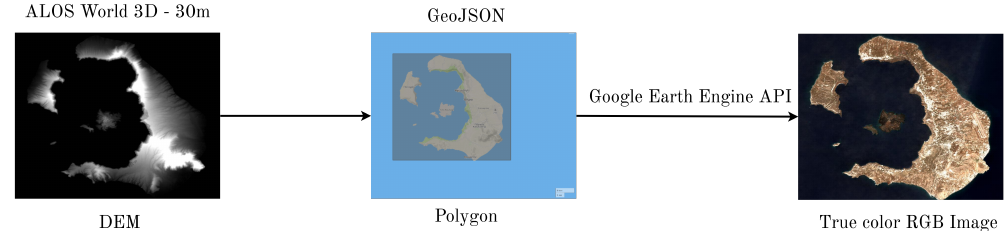
Figure 3. Flow chart of the satellite-imagery dataset collection process using the Google Earth Engine API. The outermost points of the georeferenced DEM are selected as the boundary for the GeoJSON Polygon, which when fed into the API returns the corresponding RGB satellite image.